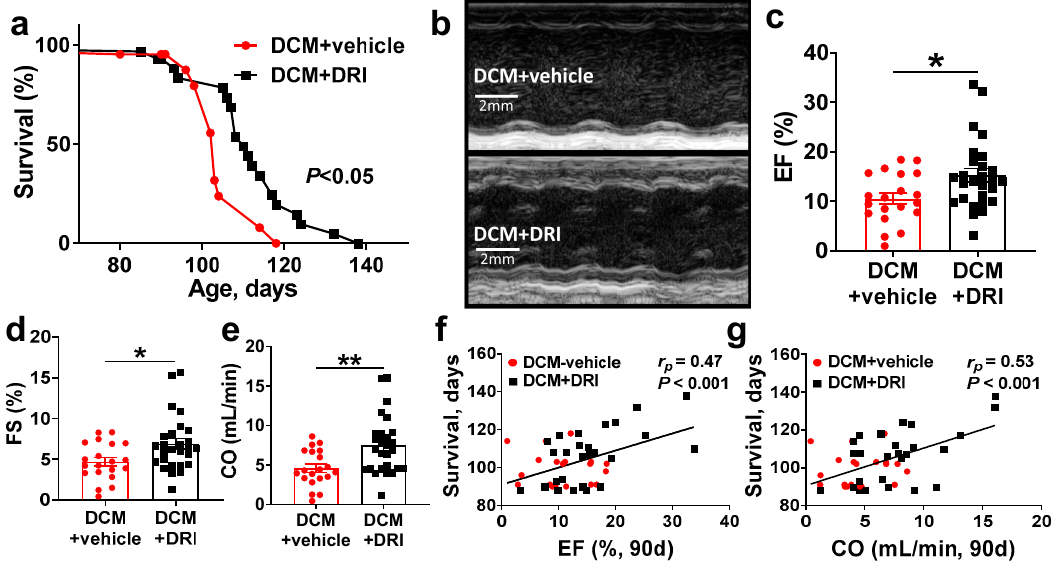
Figure 2. Direct renin inhibitor (DRI) treatment significantly improves survival and systolic function in mice with dilated cardiomyopathy (DCM). ( a ) Kaplan–Meier survival curves of control mice with DCM (DCM + vehicle, red, n = 13 deaths + 8 censored) vs. DCM mice treated with DRI (DCM + DRI, black, n = 21 deaths + 8 censored). WT ( n = 4) values are provided for reference. ( b ) Short axis m-mode examples of DCM + vehicle and DCM + DRI treated mice at 90 days of age. ( c,d ) Left ventricular systolic function measured as ejection fraction (EF, WT = 62.8%) and fractional shortening (FS, WT = 34%). ( e ) Di ff erences in cardiac output (CO, WT = 15.5 mL / min) between DCM + vehicle and DCM + DRI mice. ( f ) Pearson’s correlation analysis of 90-day EF and ( g ) CO vs. survival. DCM control mice (DCM + vehicle, red-circle, n = 20), DCM mice treated with DRI (DCM + DRI, black-square, n = 27). Di ff erences between groups were analyzed by Mantel–Cox test and Mann–Whitney test. Pearson’s correlation coe ffi cient ( r p ) and p -values are shown. Data are represented as mean ± SE, * p < 0.05, ** p < 0.01 (DCM + vehicle vs. DCM + DRI).